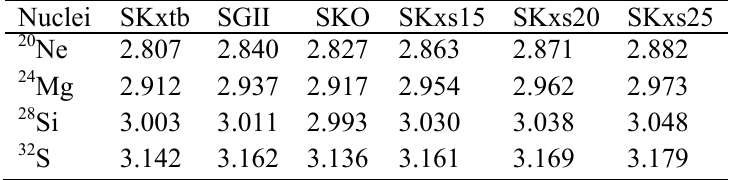
Table 5: Calculated matter rms